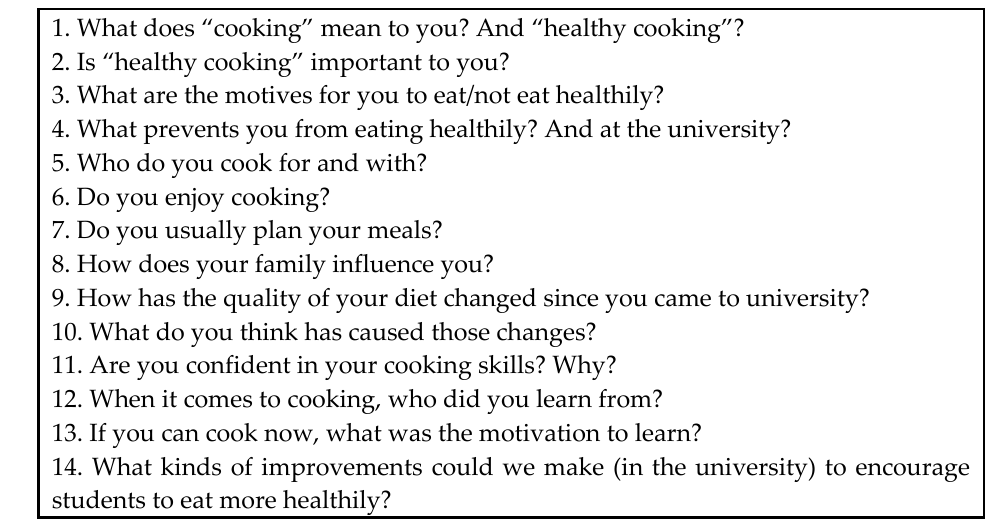
Figure 1. List of questions.